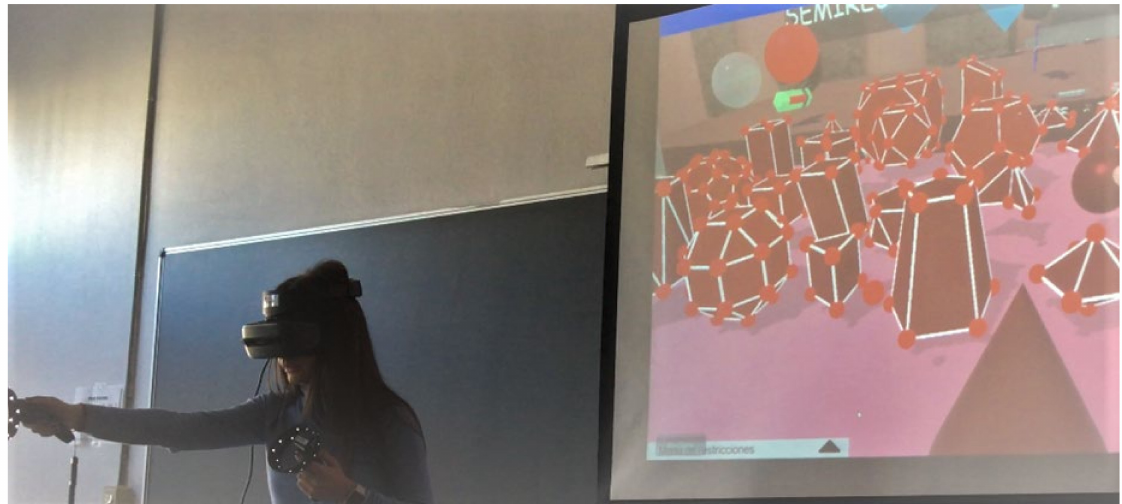
Figure 10. Polyhedron Classification from examples and